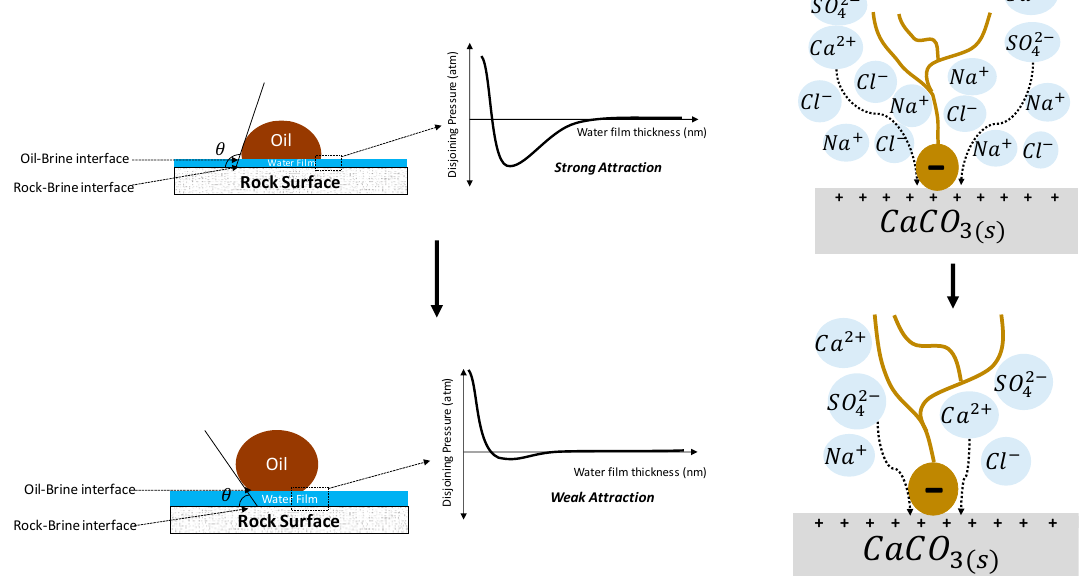
Figure 14. An illustration of the proposed mechanism for wettability alteration by “DLE” in oil-brine-carbonate rock system with DLVO disjoining pressure showing transition from an oil wetting state (left upper ) with crowded double layer-filled non-active ions ( right upper ) to water wetting state ( left lower ) with double layer depleted non-active ions ( right lower ) (adapted from Fathi et al. [28], Awolayo et al. [62]).